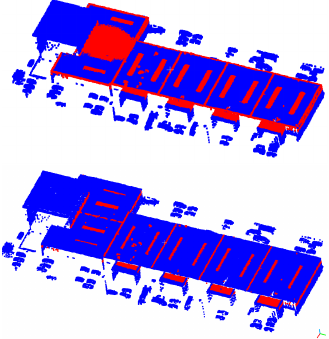
Figure 11. Regarding the distance threshold , at 20 cm, confusion between ‘deviations’ and slightly sloped roofs that were reconstructed as flat ones occurred (top, red spot on the left). On the other hand, at 40 cm (bottom), such confusion did not appear anymore but critical seeds of the most important ‘deviation’ objects were still identified (e.g. all missing windows have a number of red